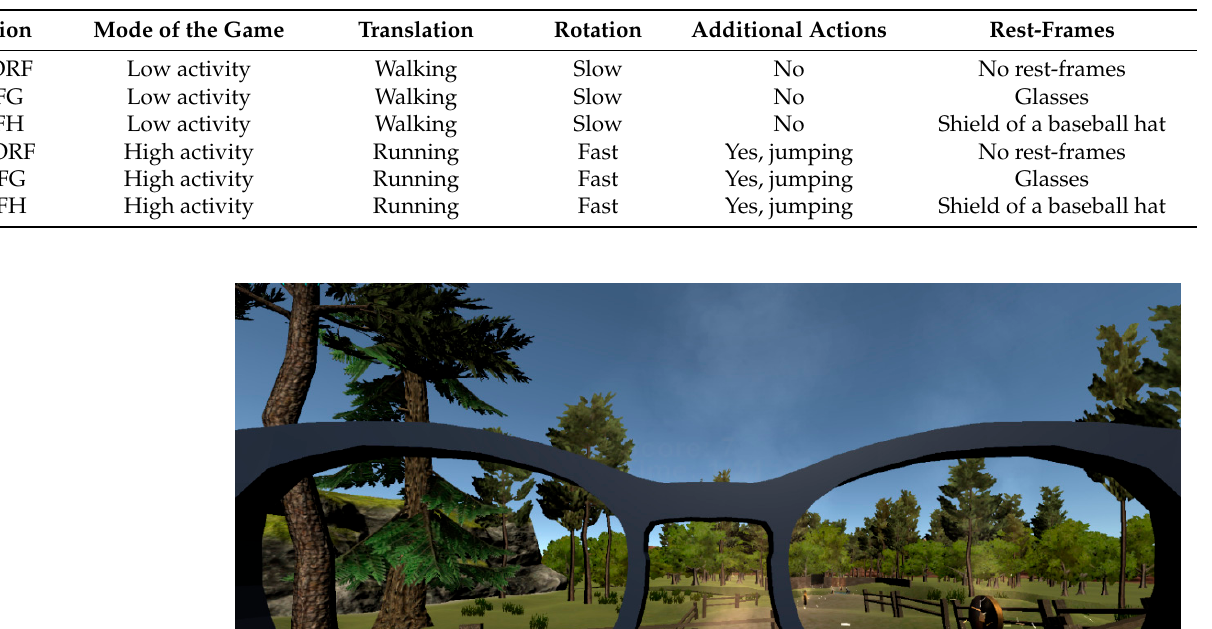
Table 1. Comparisons of the conditions used in the study. The condition without the rest-frames is referred to as NORF, condition with rest-frames glasses as RFG, and condition with the baseball hat as RFH.